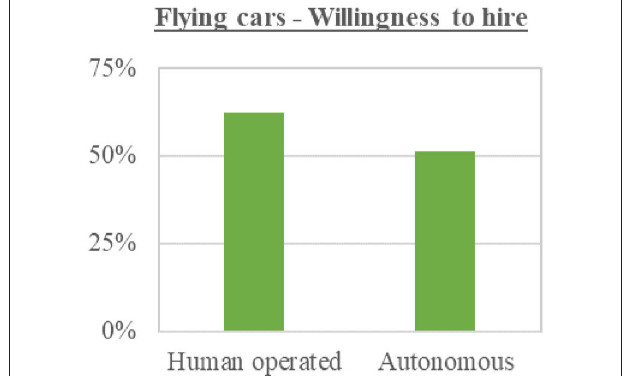
FIGURE 6 | Benefits of flying cars.